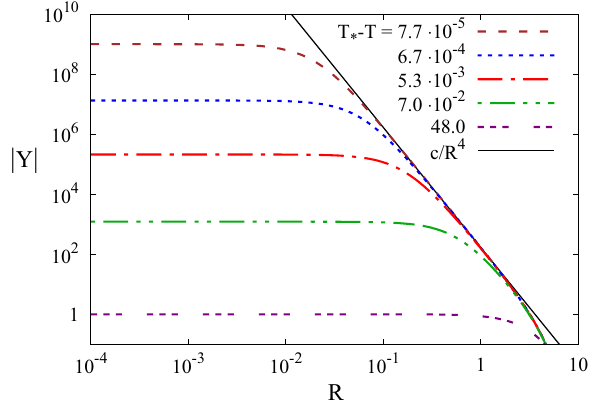
Fig. 6 Profile of the complex scalar field Y ( T , R ) for Ω in = 0 . 6 at different moments of time T . Here c ≈ 170, T ∗ ≈ 48 Q-balls with 0 . 38 (cid:2) Ω in < 1 √ drop some charge and turn 2 into the classically stable Q-balls. Below we will discuss all these ways of the unstable Q-ball evolution in more